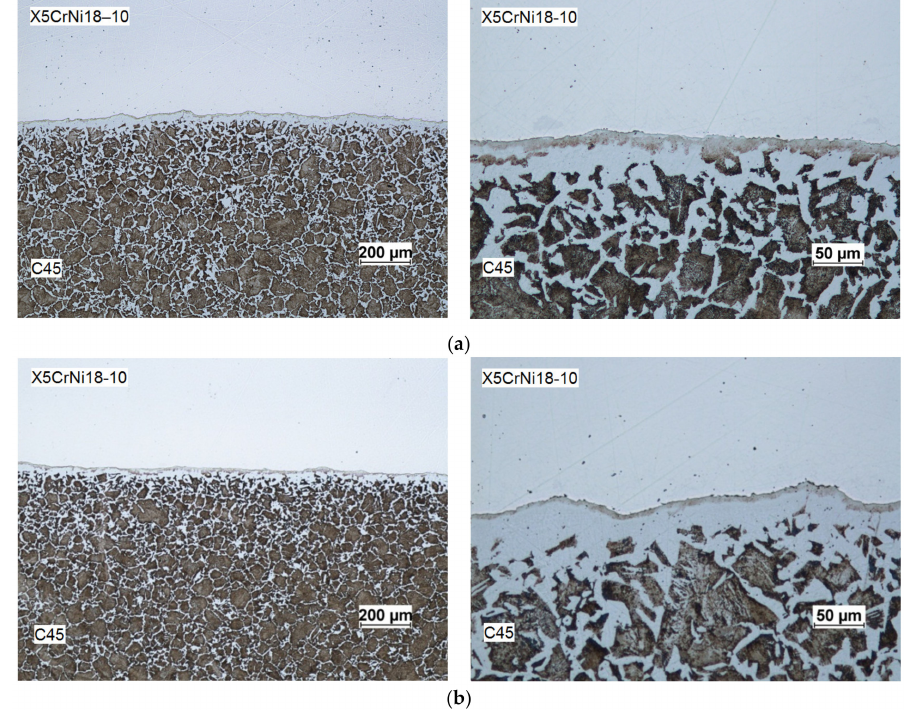
Figure 9. Microstructure of rolled bimetallic rods (a X5CrNi18–10 steel outer layer and a C45 steel core): ( a ) I variant of the research; ( b ) II variant of the research.